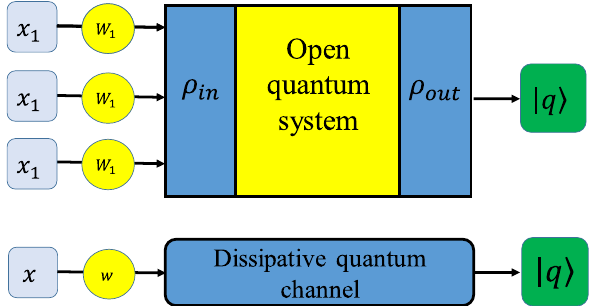
Figure 3. A quantum single-neuron with three input signals composed of three electro-optical modulators, a DQC, and an output signal. The initial signals are adjusted by modulators and then enter the DQC to be processed. The input and output of DQC are the initial and steady state of a two-qubit system. The output of the quantum neuron can be obtained by measuring the outcome of the DQC. The bottom part shows a compact schematic of the single neuron which constitutes the